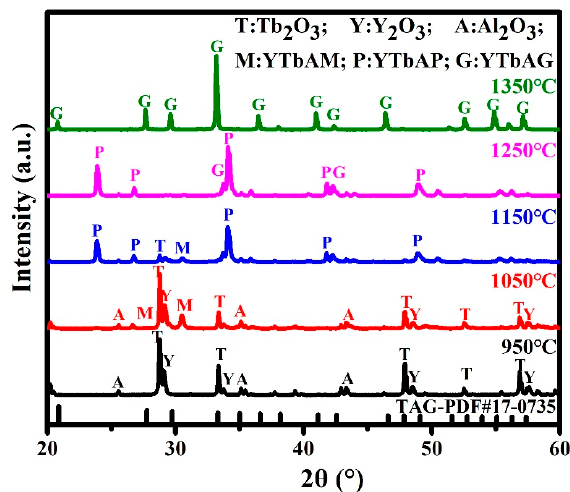
Figure 1. XRD patterns of (Tb 0.6 Y 0.4 ) 3 Al 5 O 12 pre-sintered every 100 ◦ C from 950 to 1350 ◦ C, in